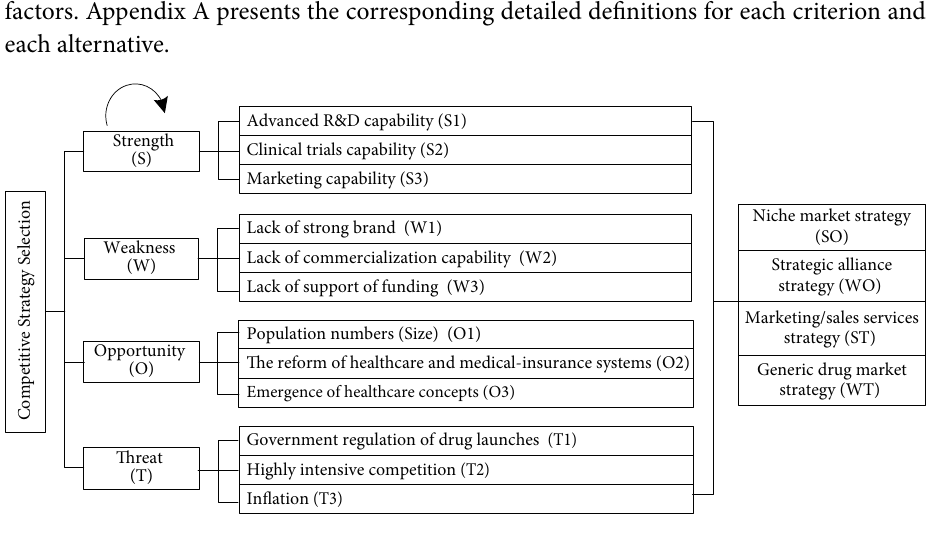
Fig. 2. A SWOT-ANP model for strategy